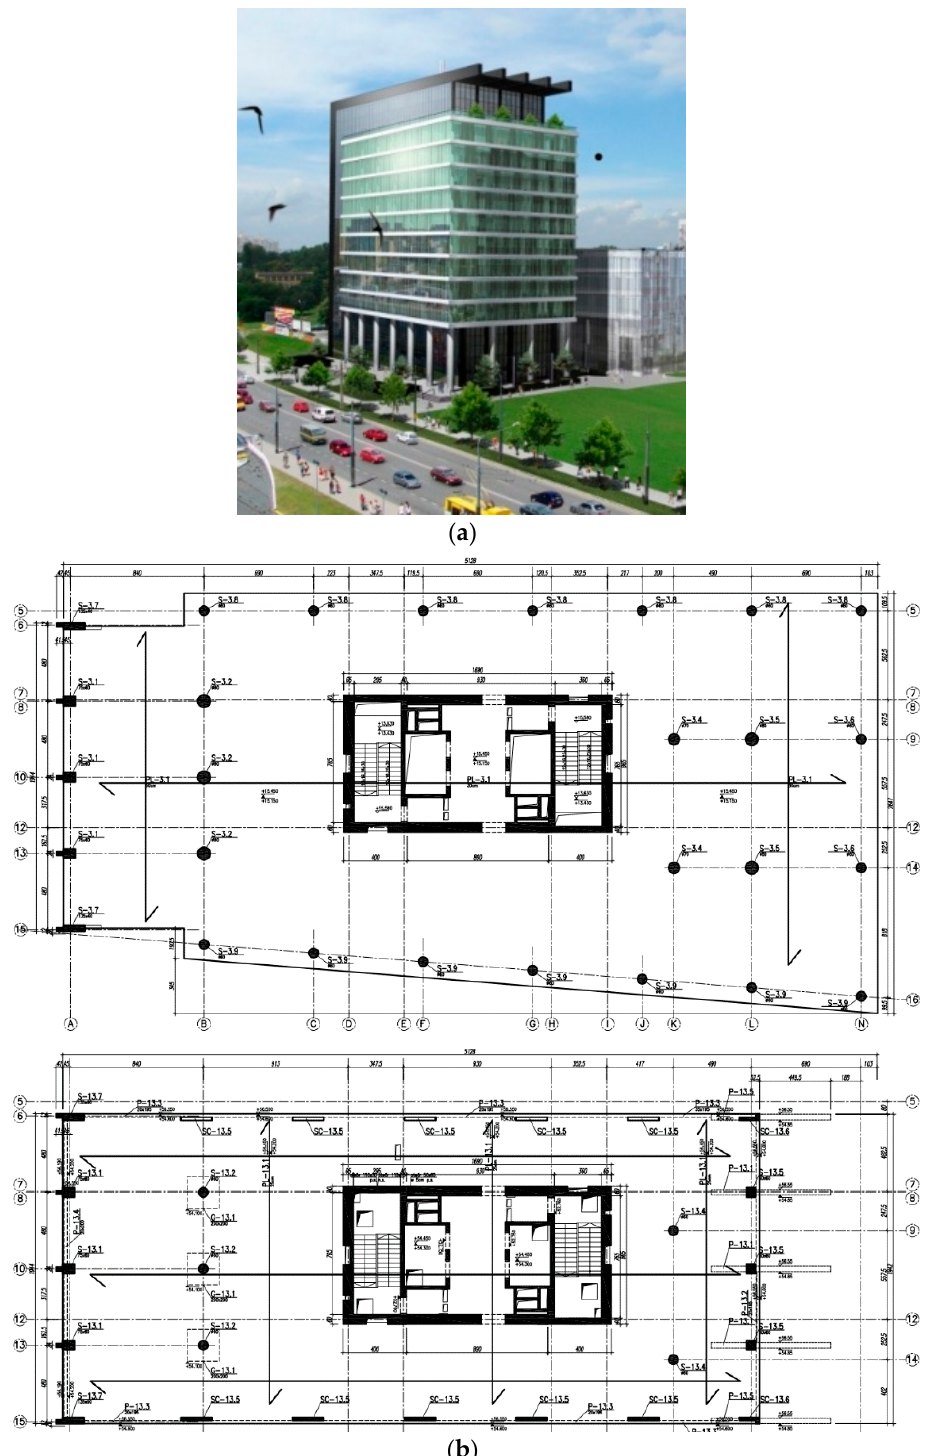
Figure 17. ( a ) Visualization of a tall building: ( b ) structural plan of floors 2 and 13 (top floor of the building).